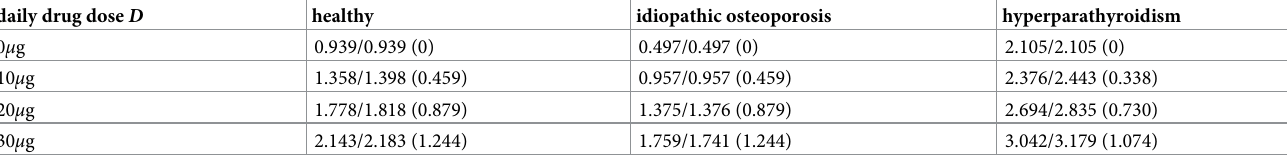
Table 2. Computed cellular responsiveness for different PTH doses using model 1 and model